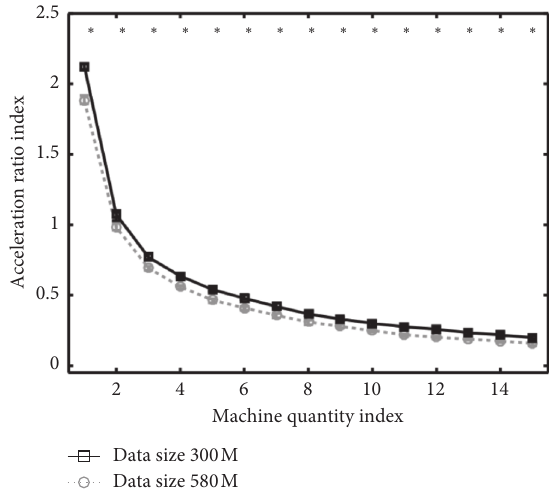
Figure 6: Examples of LWLR acceleration ratio. Table 5: The extension data mining method for extension architectural technology planning.